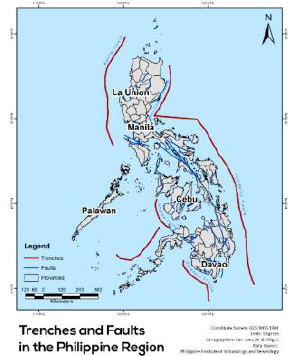
Figure 3. Trenches and Faults in the Philippine